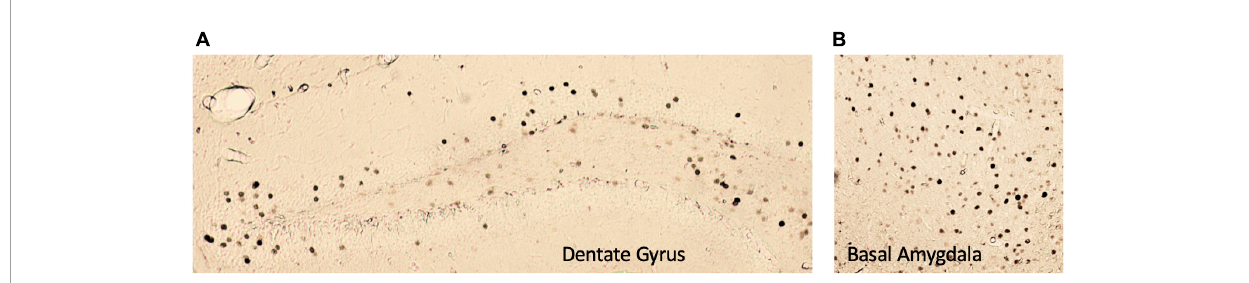
FIGURE6 Corticosterone treatment increased neural activity in the dentate gyrus during context re-exposure. The density of c-Fos+ cells in the (A) CA1 and (B) CA3 were not affected by history of footshock or corticosterone administration. (C) In the dentate gyrus (DG), c-Fos+ cell density was greater in corticosterone-treated animals than control animals. The coefficient plot on the right of each panel shows the effect sizes of the predictors with a 95% confidence interval. The orange points represent the effect sizes of the predictors in the top model, while the gray represents the predictor effect sizes of the model that includes the CORT × Shock interaction term. Only in the dentate gyrus does corticosterone treatment appear as a predictor in the top model, with a significant positive effect on neural activity. ∗ P < 0.05; ∗∗ P < 0.01; ∗∗∗ P < 0.0001.